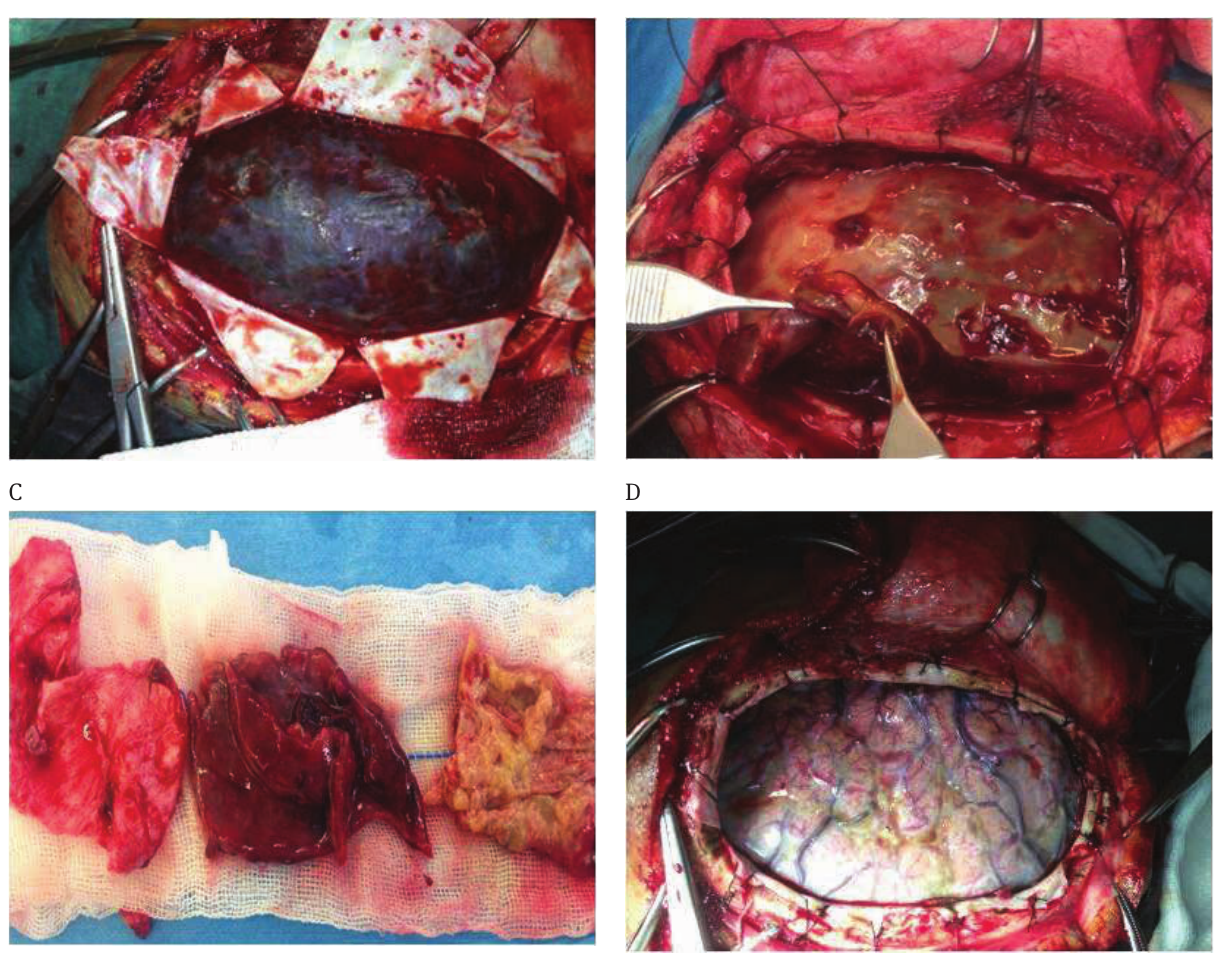
Figure 1: Intraoperative